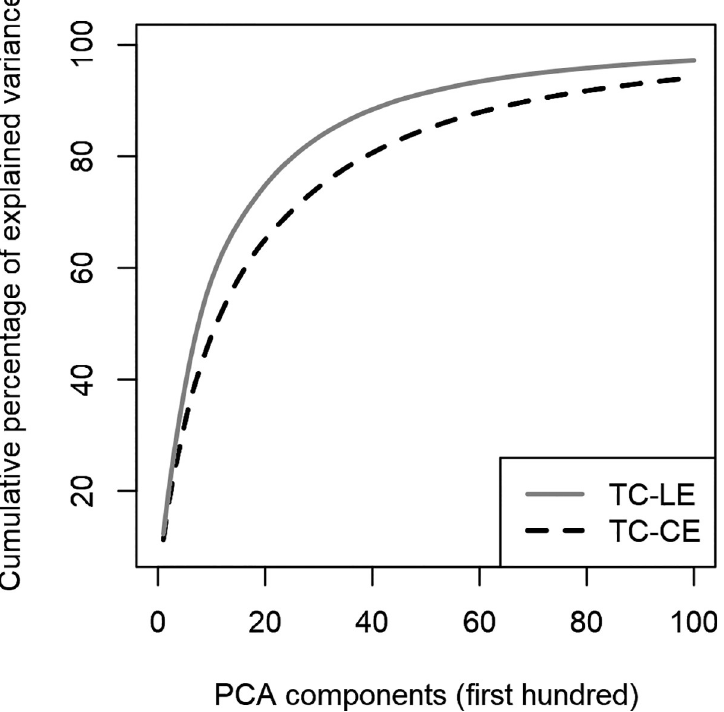
Fig 6. Comparison between TC-LE and TC-CE PCA distributions. The lines represent the cumulative percentage of explained variance for the first 100 components of TC-LE and TC-CE networks. A lower explained variance per factor implies a higher